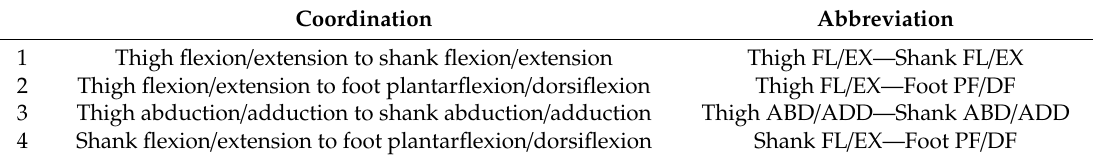
Table 1. The calculated segment coordination and its